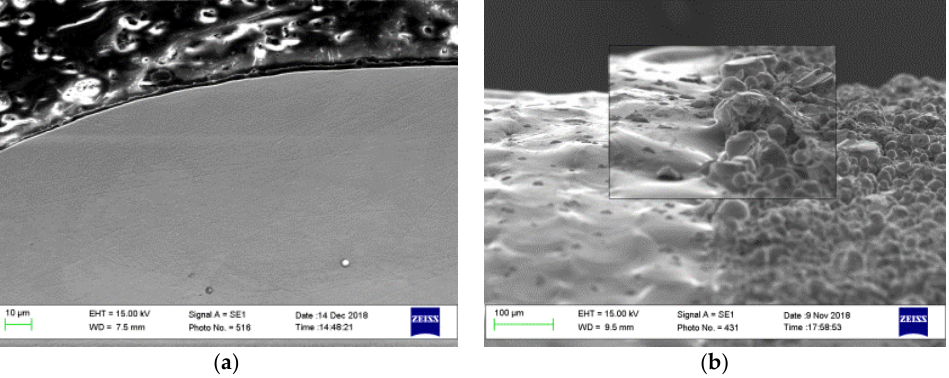
Figure 8. SEM micrograph shows ( a ) the cross-sectional view of the polished sample and ( b ) the side view. This sample was processed with 110 W, 20% overlap, and 20 rpm, and the laser beam was focused on the sample surface.